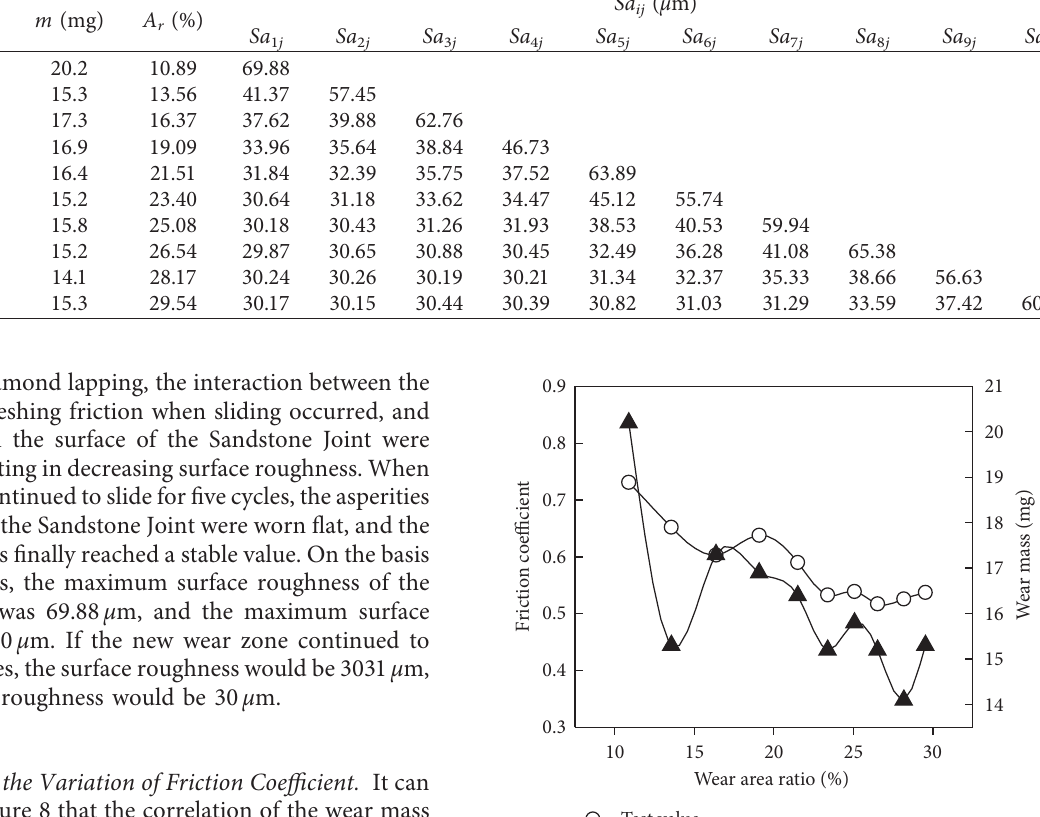
Table 1: Wear mass ( m ), total wear area rate ( A Number of cycles